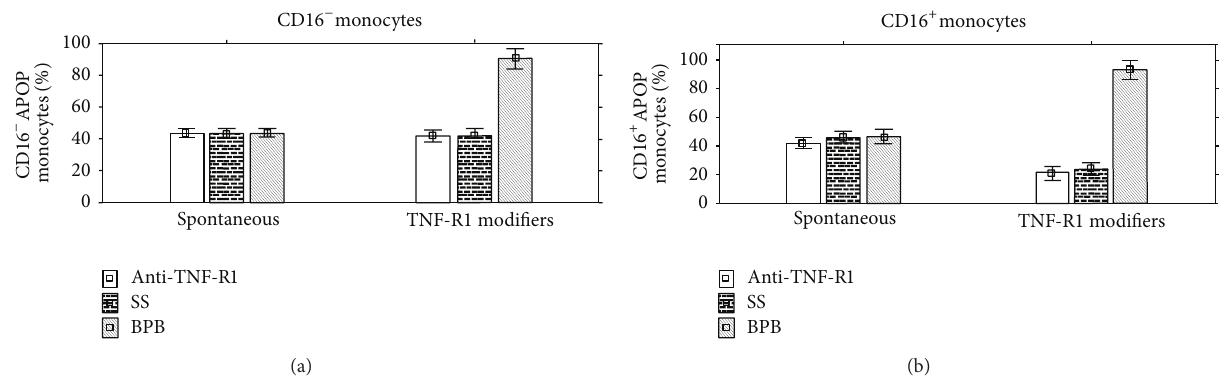
Figure 3: Effect of TNF-R1 modifiers on CD16 − and CD16 + patients’ monocytes apoptosis. Blood was taken from 10 DM1 patients. Peripheral blood mononuclear cells were isolated and incubated for 24 h in culture medium either without additives or with one of the following substances: anti-TNF-R1 mAb (10 𝜇 g/mL), 4-bromophenacyl bromide (BPB) (16 𝜇 M), and sodium salicylate (SS) (10mM). After incubation the cells were stained for visualization of CD14, CD16, and Annexin V binding molecules on monocytes. The percentage of CD16 − and CD16 + apoptotic cells was summarized from 3 experiments and presented as arithmetic mean ± S.D. Statistical significance was calculated with Kruskal-Wallis Anova test. Statistical significance for CD16 − monocytes: BPB ( 𝑃 = 0.00002 ); statistical significance for CD16 + monocytes: anti-TNF-R1 mAb ( 𝑃 = 0.00002 ), SS ( 𝑃 = 0.0002 ), and PBP (𝑃 = 0.0002) . Anti-TNF-R1: mAb against TNF-R1 receptor; APOP: apoptotic BPB: 4-bromophenacyl bromide; SS: sodium